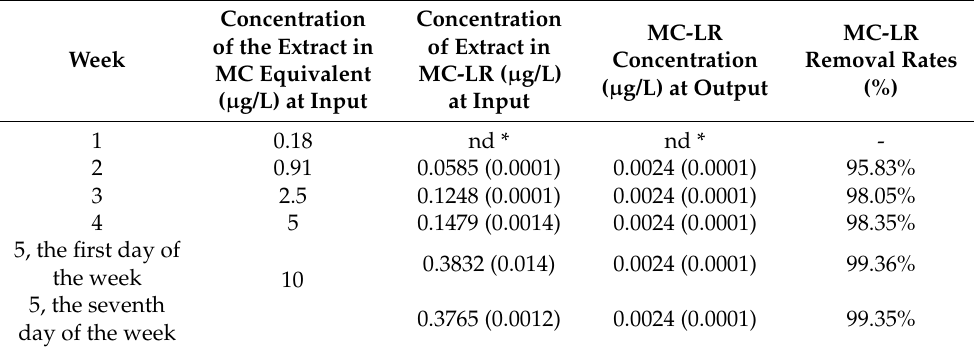
Table 1. MC-LR concentrations in the influent and effluent of the MSL system (mean and standard deviation, n = 3) and removal rates.